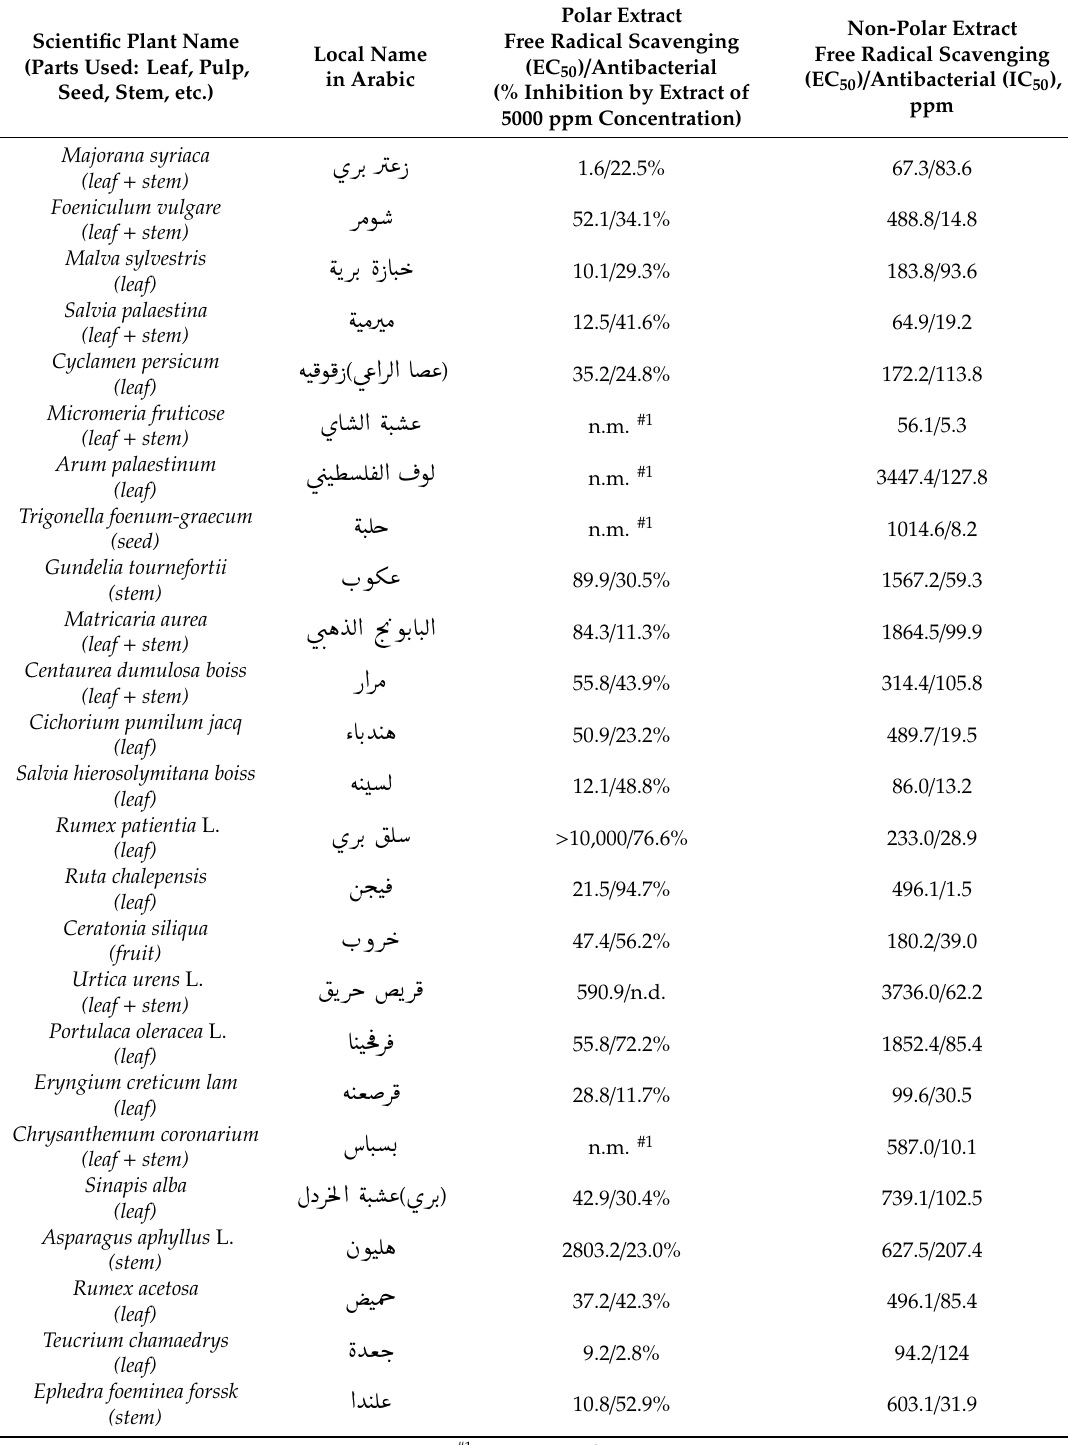
Table 1. List of tested plants and their extracts’